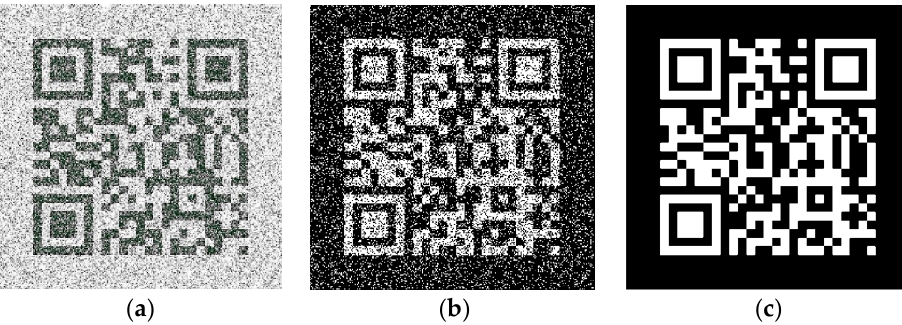
Figure 3. ( a ) is a noisy image of a QR tag; ( b ) is the binarization image of the image in ( a ); ( c ) is the ground truth of the image in ( a ).